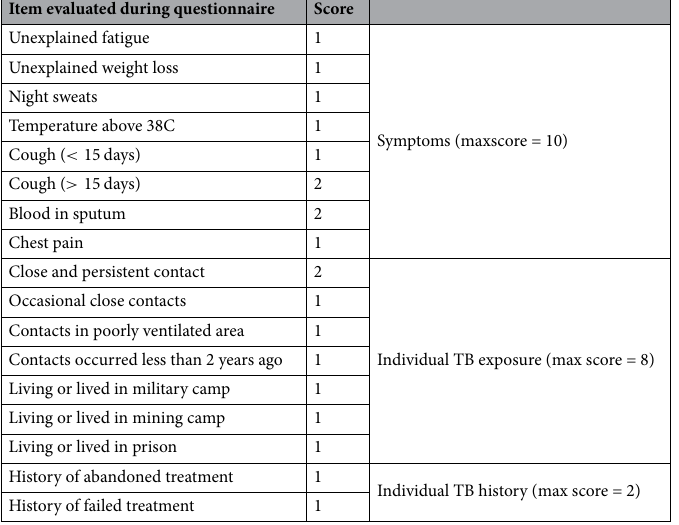
Table 3. Elements and corresponding weights used to evaluate individual risk for TB in the